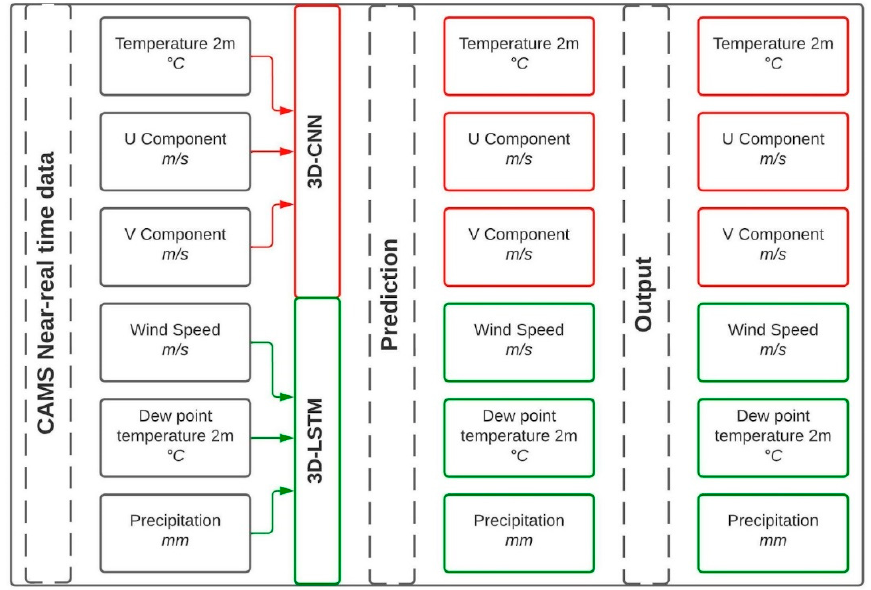
Figure 2. Flowchart of the inputs, models and outputs of the 3D neural networks. Notice that each model focuses on three variables due to their forecasting performance. This is denoted with the arrow colors and the edge color of the boxes.